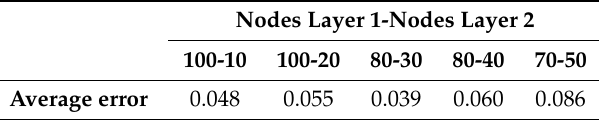
Table 2. Error distance in cm.